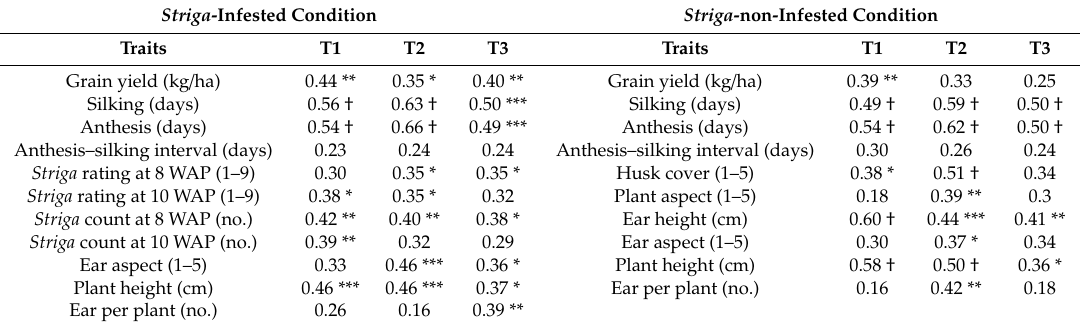
Table 6. Kendall’s coe ffi cient of concordance (W) for ranks of yellow maize inbred lines by each tester across environments under Striga -infested and non-infested conditions.